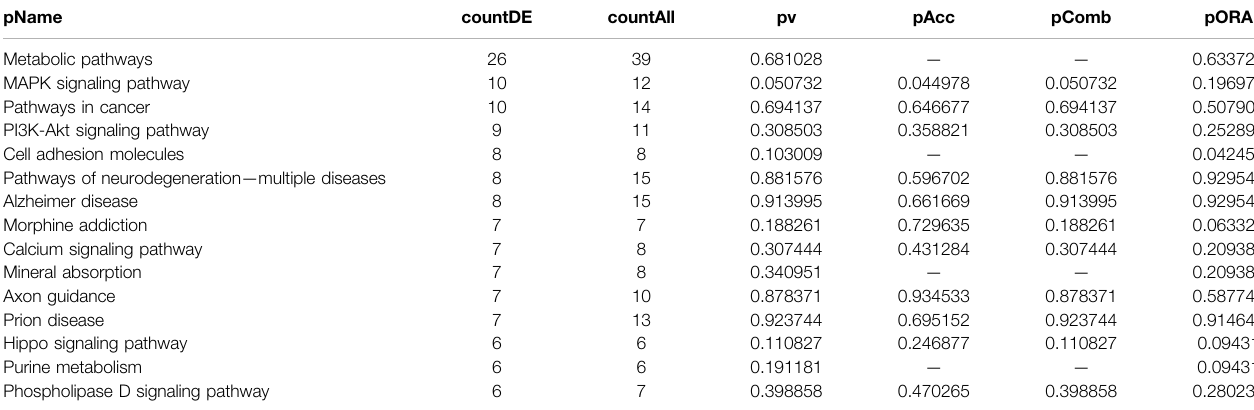
TABLE 3 | Top 15 pathways ranked based on their associated differentially expressed genes derived from astrocytes based on the comparison AD00205 (disease) vs. AD00201 (control).